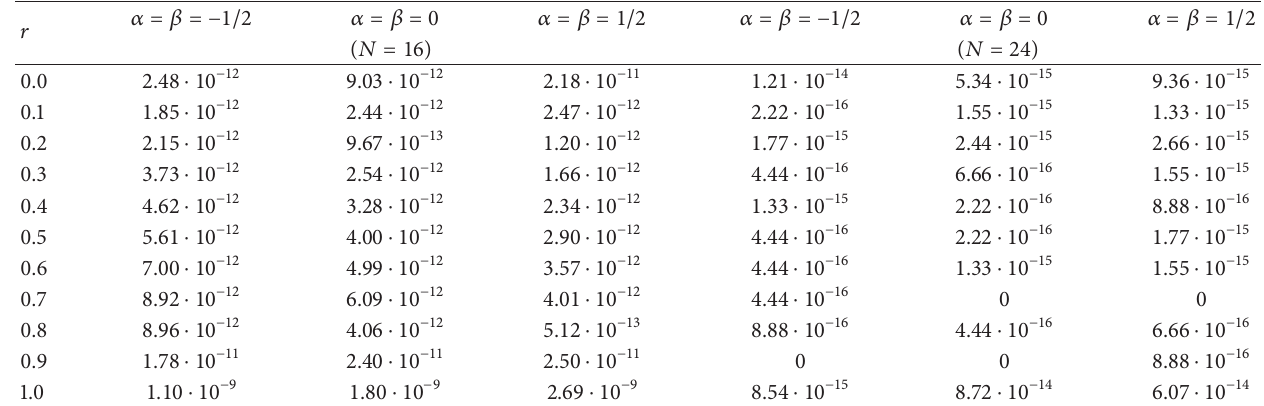
Table 4: Absolute residual error functions for 𝑛 = 3, 𝜆 = 4/3 .